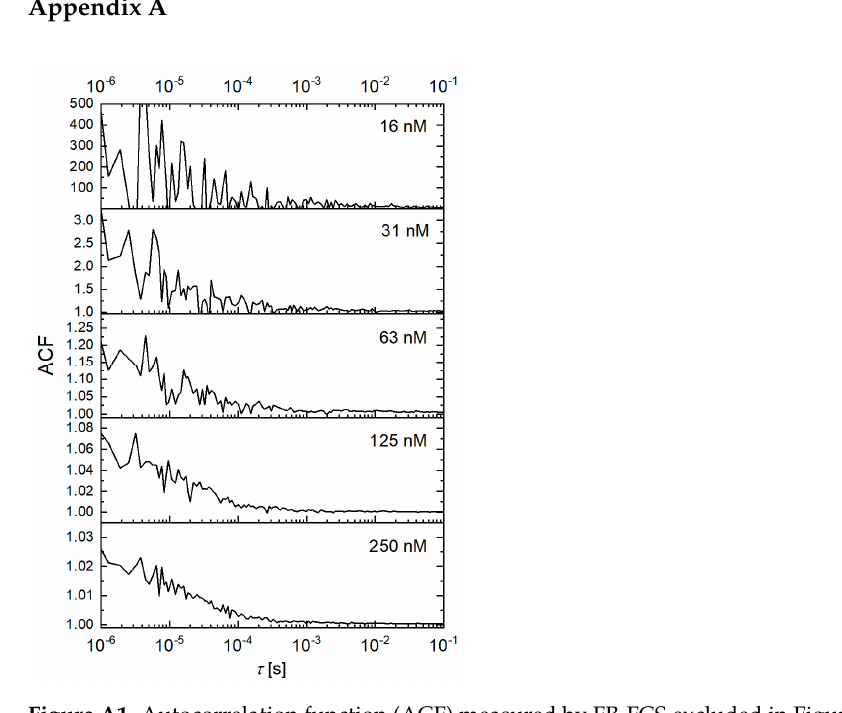
Figure A1. Autocorrelation function (ACF) measured by FB-FCS excluded in Figure 2a.